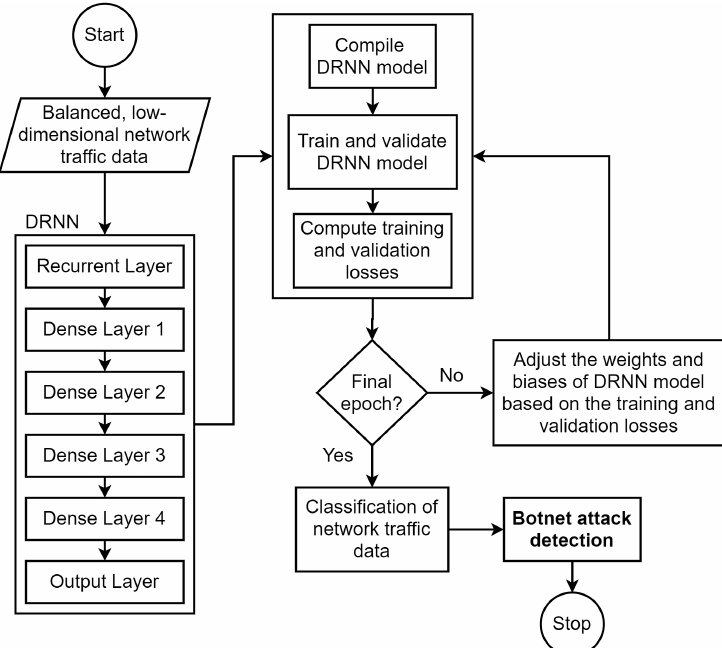
Figure 4. DRNN model for multi-class classification.